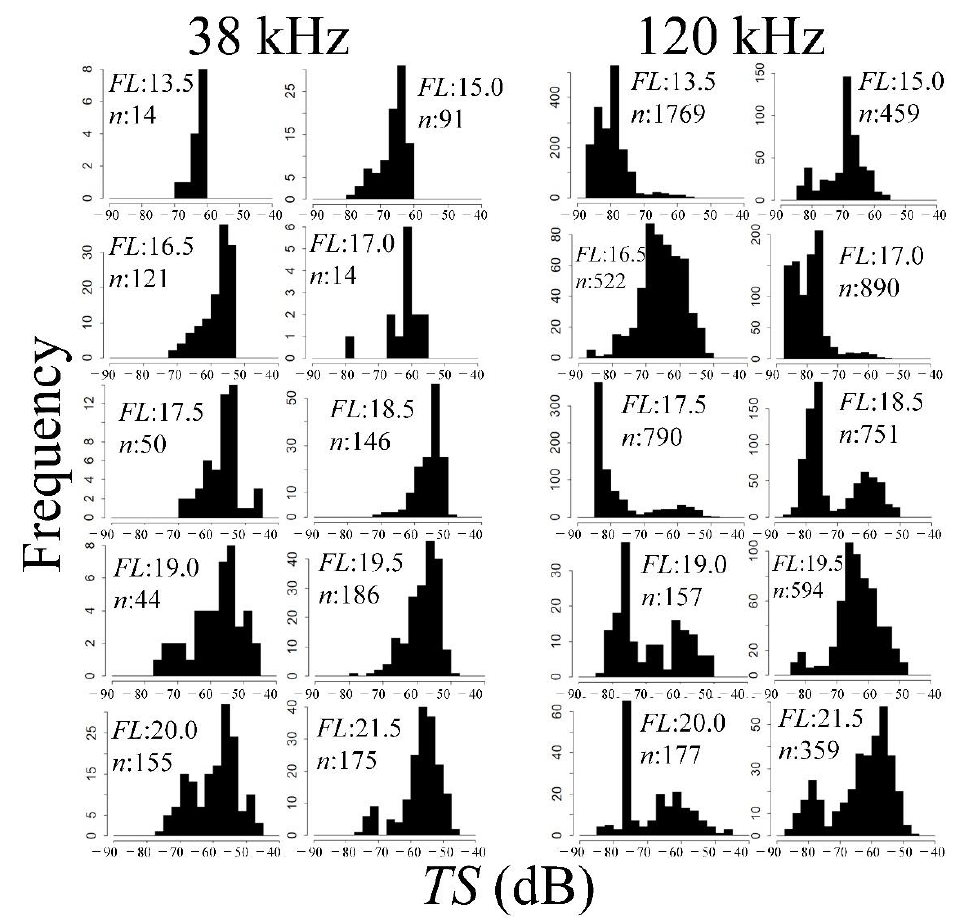
Figure 2. TS histogram of sandeel for each fork length ( FL ) at 38 kHz and 120 kHz in this study. n shows the number of acoustic pings.